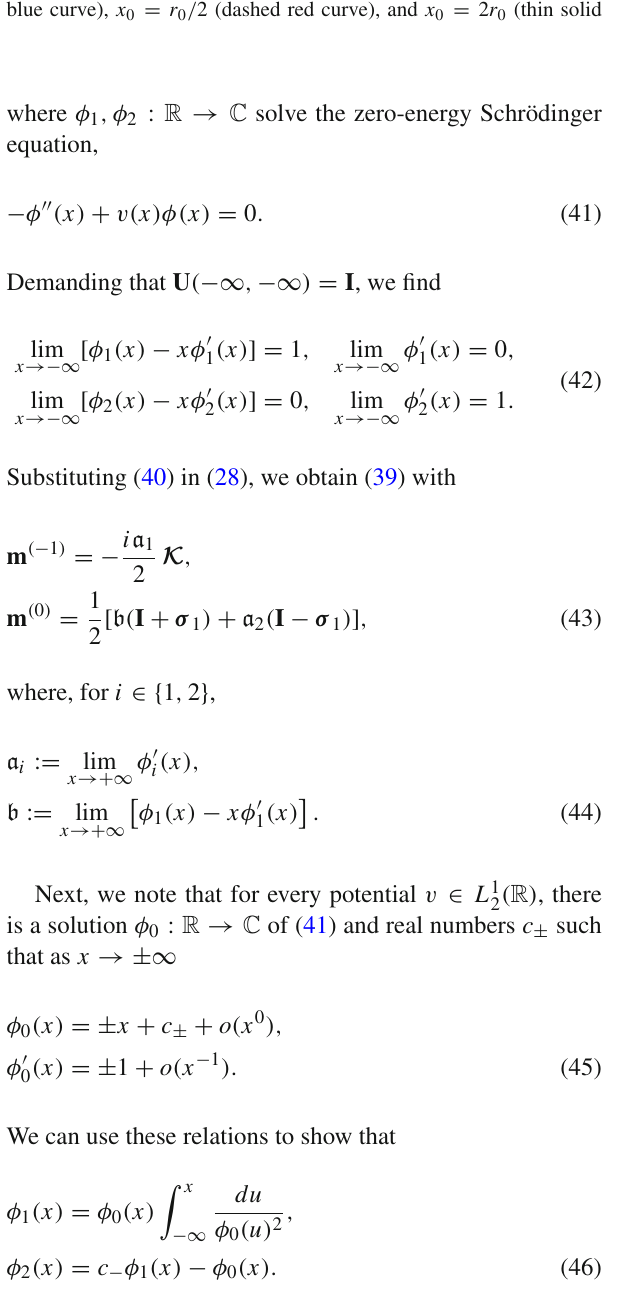
green curve) on the left, and x 0 = r 0 and l = 0 (thick solid blue curve), l = 1 (dashed red curve), and l = 2 (thin solid